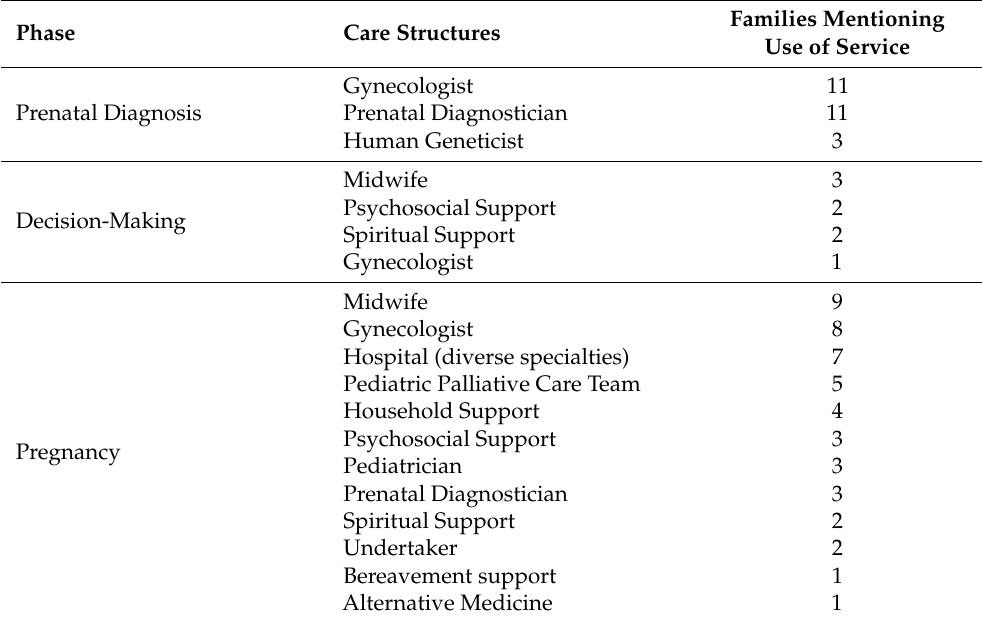
Table 2. Utilization of existing structures of care ( n =